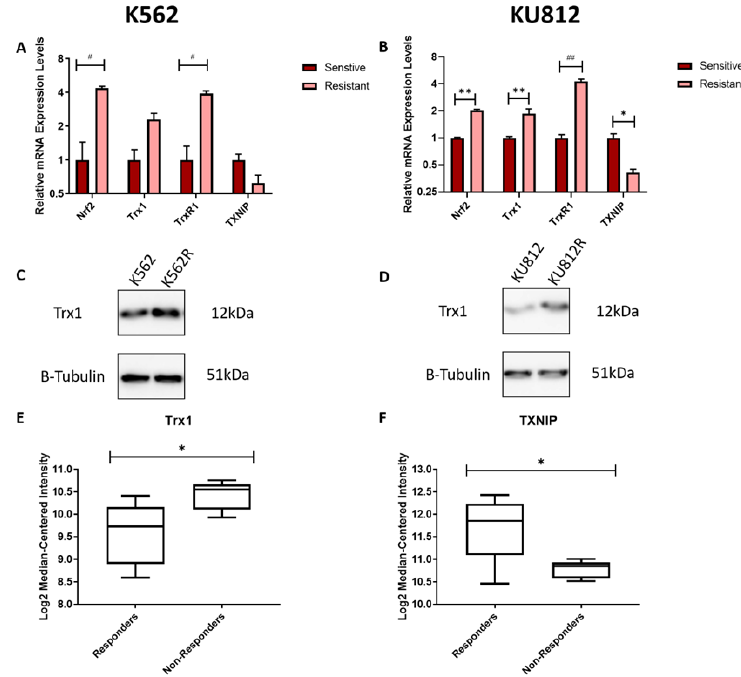
Figure 5. Imatinib Resistant CML cells have Upregulated mRNA and Protein Expression of the Trx System. A,B : mRNA expression levels of Nrf2, Trx1, TrxR1, and TXNIP were measured using RT-qPCR in sensitive and Resistant K562 and KU812 CML cells respectively, with the sensitive cells being used as a control. RPL32 was used as a normaliser. C,D : Protein levels of Trx1 were measured in sensitive and resistant K562 and KU812 CML cells respectively. B-tubulin was used as a loading control. E,F : Database analysis of the mRNA expression levels of Trx1 and TXNIP respectively were compared against samples from CML patients who showed a response to imatinib and those that did not (GSE2535). RT-qPCR results were analysed via two-way ANOVAs with Dunnett’s post hoc test. Database analysis results were analysed via an unpaired T-test. Statistical tests compared results between the sensitive and resistant cell lines. * = p < 0.05, ** = p < 0.01, # = p < 0.001, ## = p < 0.0001. N = 3 for RT-qPCR and western blotting, N = 16 for bioinformatics. Values displayed as mean ± SEM.